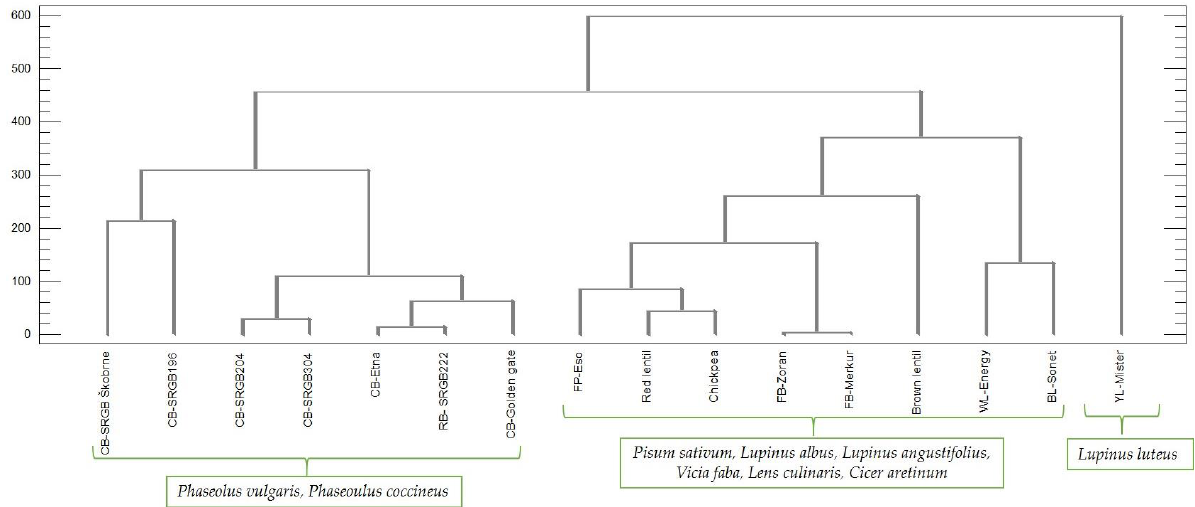
Figure 3. Dendrogram (Ward’s method, squared Euclidean distances) for 16 pulse samples according to 40 variables. CB, common bean; RB, runner bean; FP, field pea; WL, white lupin; BL, blue lupin; YL, yellow lupin; FB, faba bean. Table 4. Multi-mineral composition in the seeds of 16 pulse